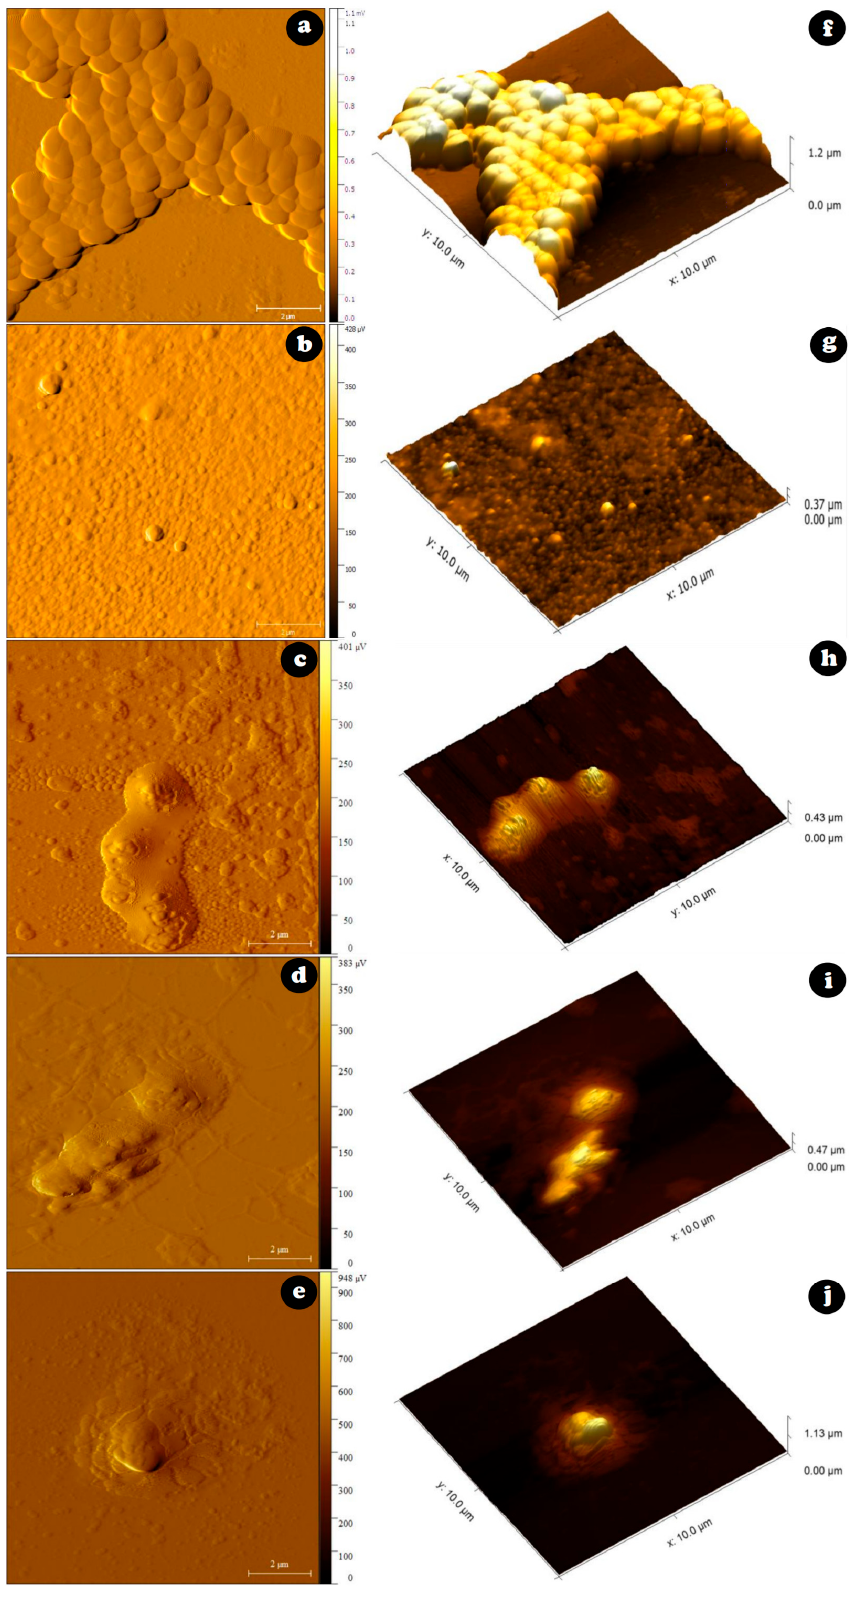
Figure 5. Atomic Force Microscopy (AFM) images from ( a , f ) Staphylococcus aureus ATCC 29213 and Co 1 − x Cu x MoO 4 · nH 2 O with x equals to ( b , g ) 0.00, ( c , h ) 0.03, ( d , i ) 0.06, and ( e , j ) 0.12.Topography image ( a – e ) and three-dimensional (3D) image ( f – j